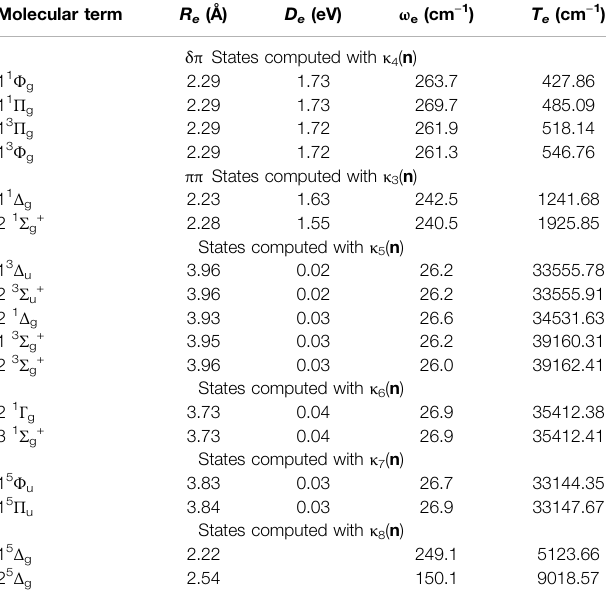
TABLE 2 | Equilibrium bond lengths, R e (Å), binding energies, D e (eV), harmonic frequencies, ω e (cm − 1 ), and adiabatic transition energies, T e (cm − 1 ), of electronicstatesofNi 2 calculatedattheGVVPT2leveloftheoryusingthecc-pVTZ basis set and reference macrocon fi gurations κ 3 ( n ) to κ 8 ( n